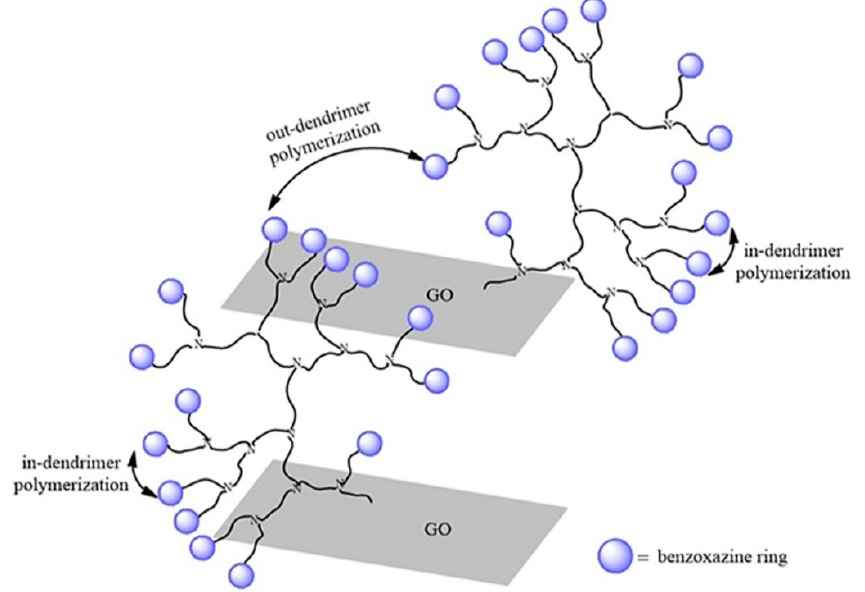
Figure 9. Polymerization routes for hybrid GO-PAMAM functionalized with benzoxazine rings.